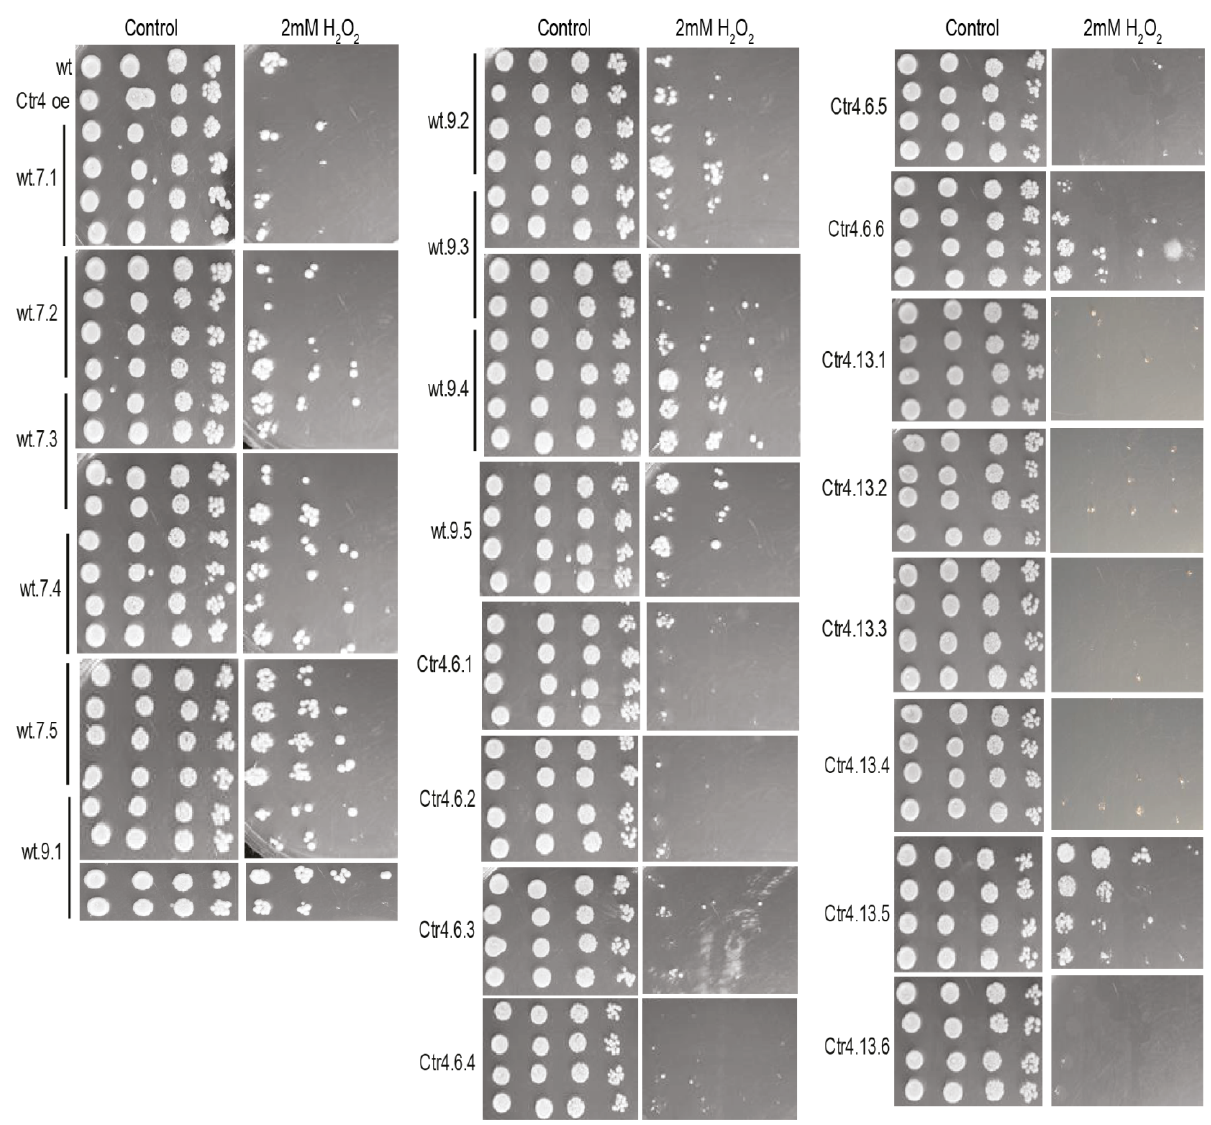
FIGURE 5: Sensitivity to H 2 O 2 due to Ctr4 overexpression is inherited in a non-Mendelian manner. Wild-type (wt) cells transformed with extract from wild-type or Ctr4 overexpressing cells (indicated with asterisks in Figure 4) were mated with wild-type cells. The four segre- gants from 10 tetrads involving wild-type transformants and from 12 tetrads involving Ctr4 transformants were spotted in serial dilutions onto YES plates without (control) and with 2 mM H 2 O 2 . Five or six full tetrads from each cross involving the wt.7, wt.9, Ctr4.6, Ctr4.13 trans- formants were examined. All plates shown have been grown together for the same times and using the same batches of